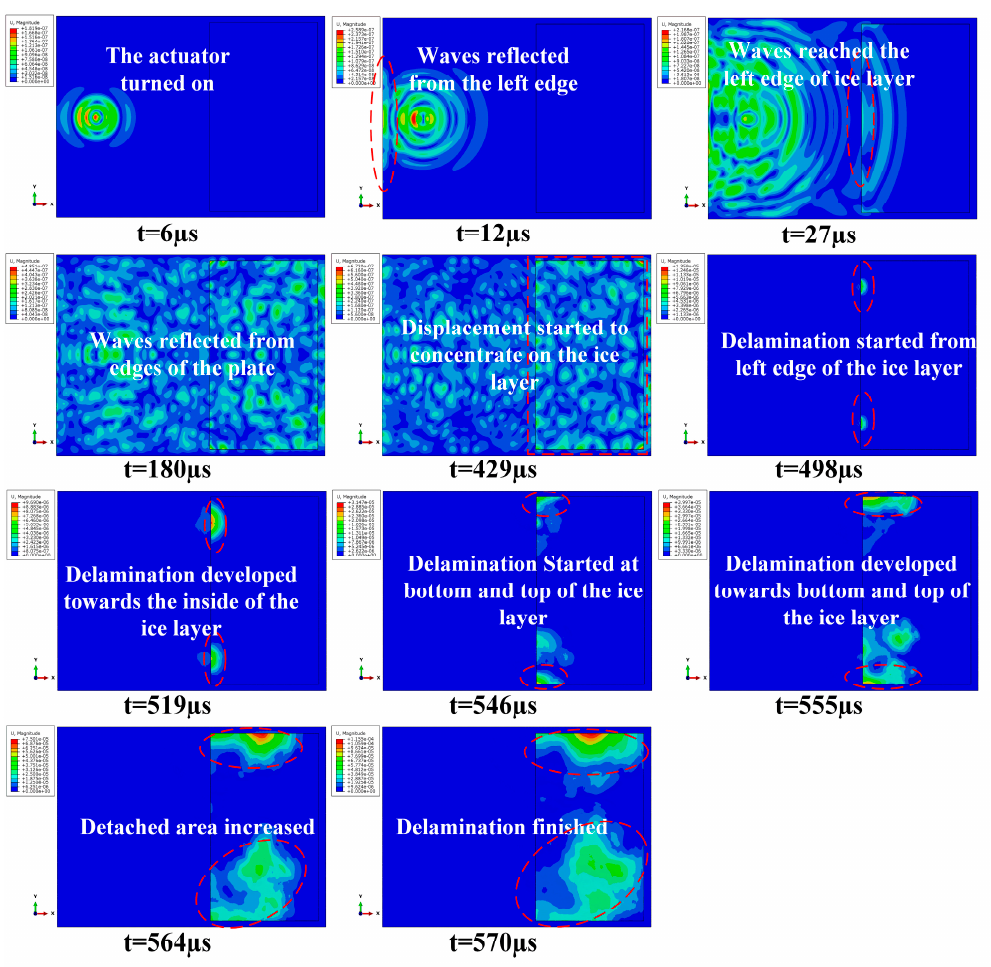
Figure 16. Displacement distribution for the aluminum plate and ice layer over time.